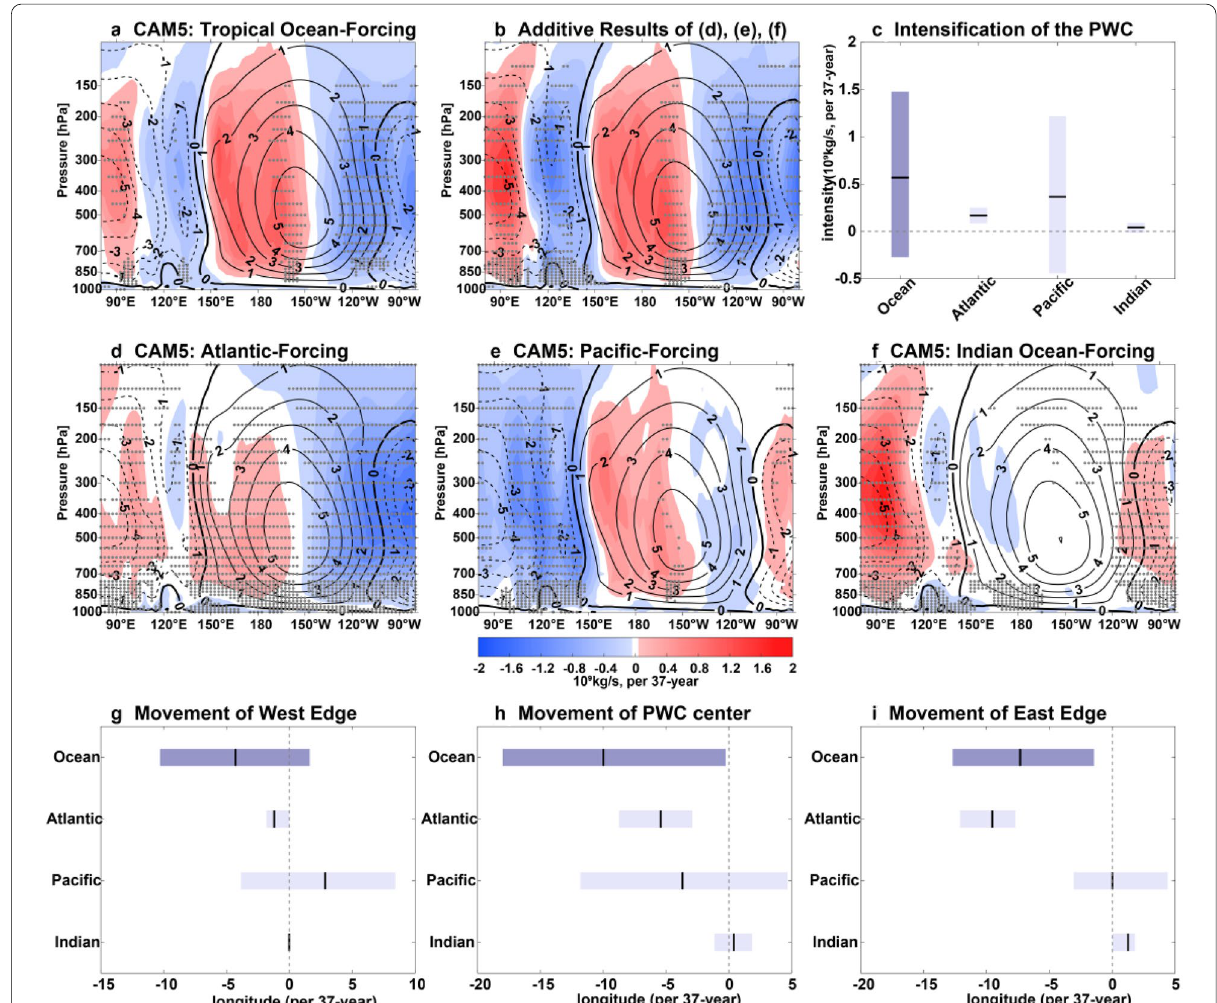
Fig. 4 The simulated trends of the PWC over the tropical Pacific in atmospheric model experiments. a Shows the simulated climatology (contours) and the trend (color) of the mass stream function of the PWC in the pan‑tropical‑ocean forcing atmospheric model experiments, with d – f showing the simulated PWC trends in the tropical Atlantic‑, the tropical Pacific‑, and the Indian Ocean‑forcing experiments. The gray dots cover the areas with confidence level of 95%. b Shows the additive effect of the three simulations as shown in d – f , which is very similar to the model results driven by the pan‑tropical oceans ( a ), implying the linearity between the SST forcings from different tropical ocean basins. c Quantifies the trends of the PWC in each of the four atmospheric model experiments, with black bars showing the amplitude of the trend and the error bars indicating the 95% confidence intervals. g – i Quantify the westward shifts of the west edge ( c ), the center ( d ), and the east edge ( e ) of the PWC in these